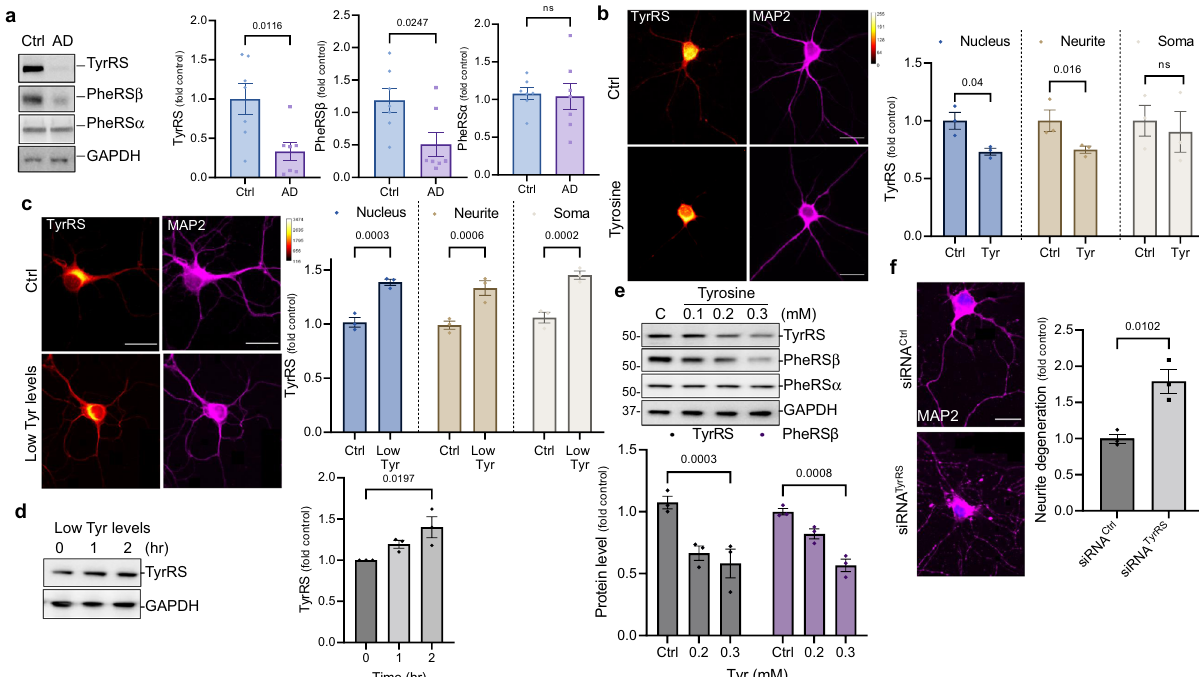
Fig. 1 TyrRS protein is decreased in the hippocampal region of AD patients, and tyrosine decreases nuclear and neurite levels of TyrRS. a Representative immunoblots and quanti fi cation for TyrRS and PheRS α / β using anti-TyrRS and PheRS α / β antibodies in the hippocampal region of AD patients ( n = 7) with age and sex-matched controls ( n = 7). b Tyrosine preferentially decreases nuclear and neurite levels of TyrRS . Spectral images (scale bar, 20 µ m) and quantitative IF analysis of TyrRS in the nucleus, soma, and neurite of rat cortical neurons (DIV 9) using anti-TyrRS antibody after treatment with L-tyrosine (250 μ M) for 4 hr ( n = 3). c Reduction in tyrosine level increases the nuclear and neurite levels of TyrRS . Spectral images (scale bar, 20 µ m) and quantitative IF analysis of TyrRS in the nucleus, soma, and neurite of rat cortical neurons (DIV 9) using anti-TyrRS antibody after treatment with low tyrosine medium for 2 hr as described in methods ( n = 3). d Reduction in tyrosine levels increase total TyrRS protein levels . Representative immunoblots showing total TyrRS after treatment with low tyrosine medium for 2 hr in rat cortical neurons (DIV 9) using anti-TyrRS antibody ( n = 3). e Tyrosine depletes TyrRS and PheRS β , but not PheRS α . Rat cortical neurons were treated with L-tyrosine (100 – 300 μ M) for 4 hr. The levels of PheRS β and PheRS α were detected by WB analysis using their speci fi c antibodies ( n = 3). f TyrRS knockdown using siRNA induces neurite degeneration . Representative images (scale bar, 20 µ m) for cortical neurons 72 hr following siRNA TyrRS transfection (MAP2 – neurite marker, magenta, and DAPI – nuclear marker, blue). Neurons were immunoassayed with anti-MAP2 antibody and quanti fi ed for neurite degeneration. The data is presented as mean ± SEM for n = 3 experiments. Statistical signi fi cance was measured using a two-tailed unpaired t -test. Source data are provided as a Source Data fi le.